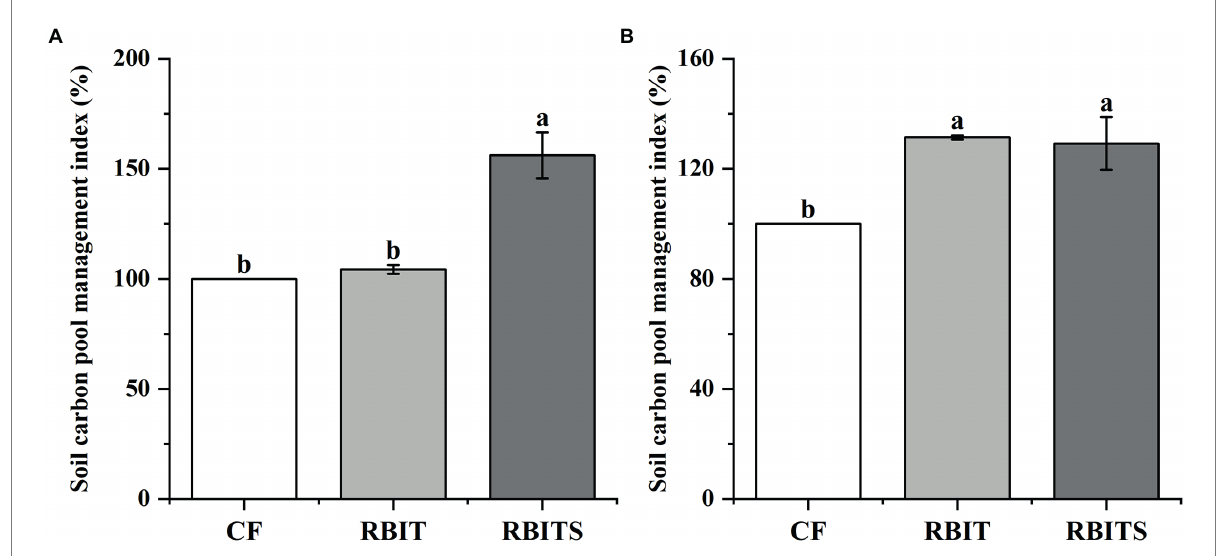
FIGURE 6 Effect of fertilization management on CMPI at depths of 0–10 cm (A) and 10–20 cm (B) after nine years. CF : conventional fertilization; RBIT: reduced basal and increased topdressing fertilizer rate; RBITS: RBIT combined with straw incorporation. The different lowercase letters represent significant differences (p ≤ 0.05) among treatments in each soil depth. Error bars are standard error (SE) of the mean.